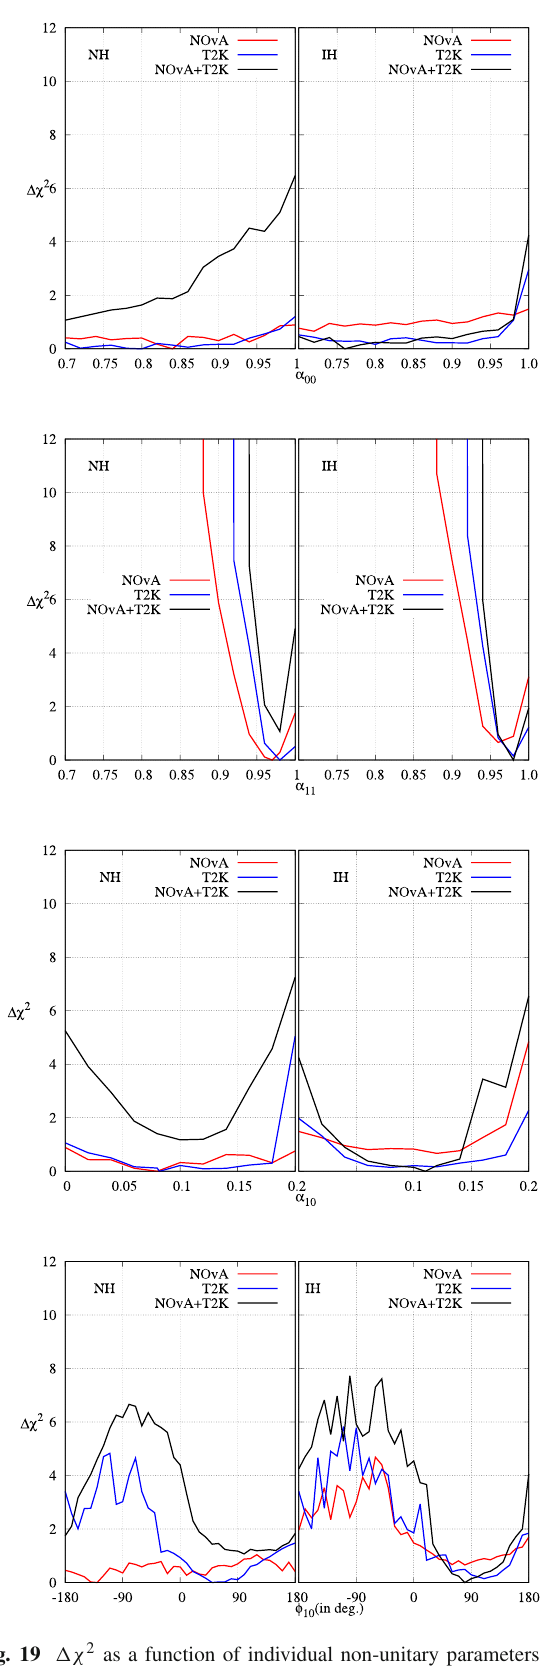
Fig. 19 (cid:6)χ 2 as a function of individual non-unitary parameters for 2020 long baseline